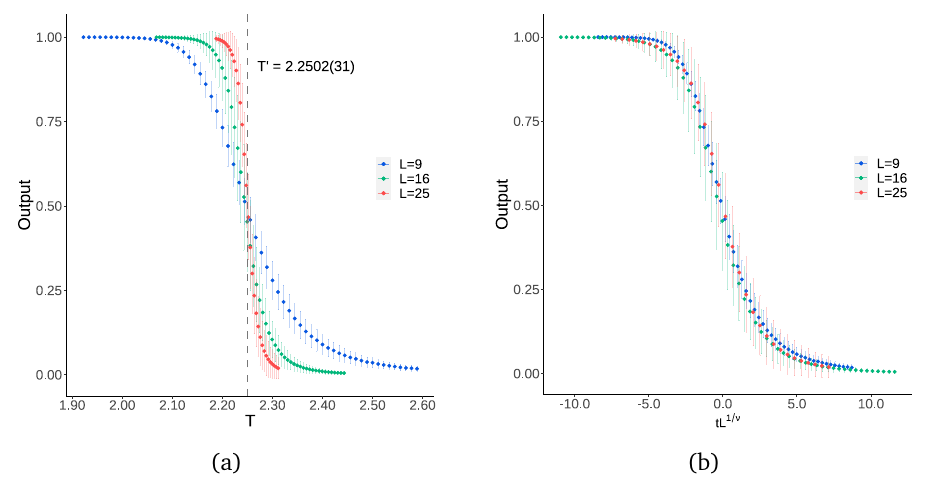
Figure 5: Three-dimensional test of the state-space reduction of training data. a , Average outputs of ANNs trained with the reduced state space versus sampling temperature for spin configurations of the three-dimensional 2-state Potts models. b , The associated finite-size scaled results. The error bars shown are 99.7% confi- dence